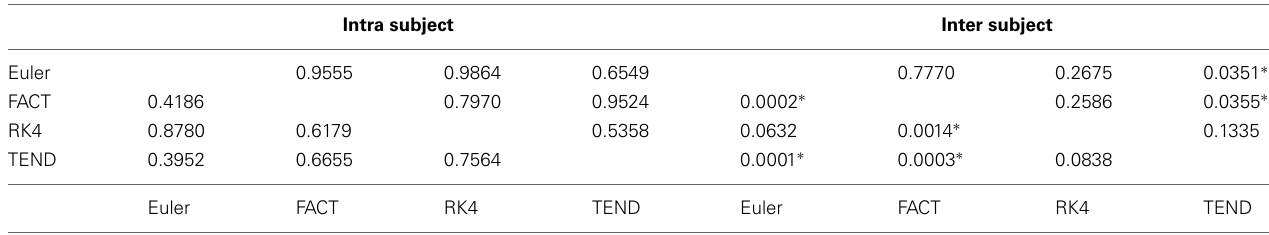
Table 1 | Functional data analysis is used along with permutation testing to look for differences in dice overlap measures between graphs generated from different fiber tracking